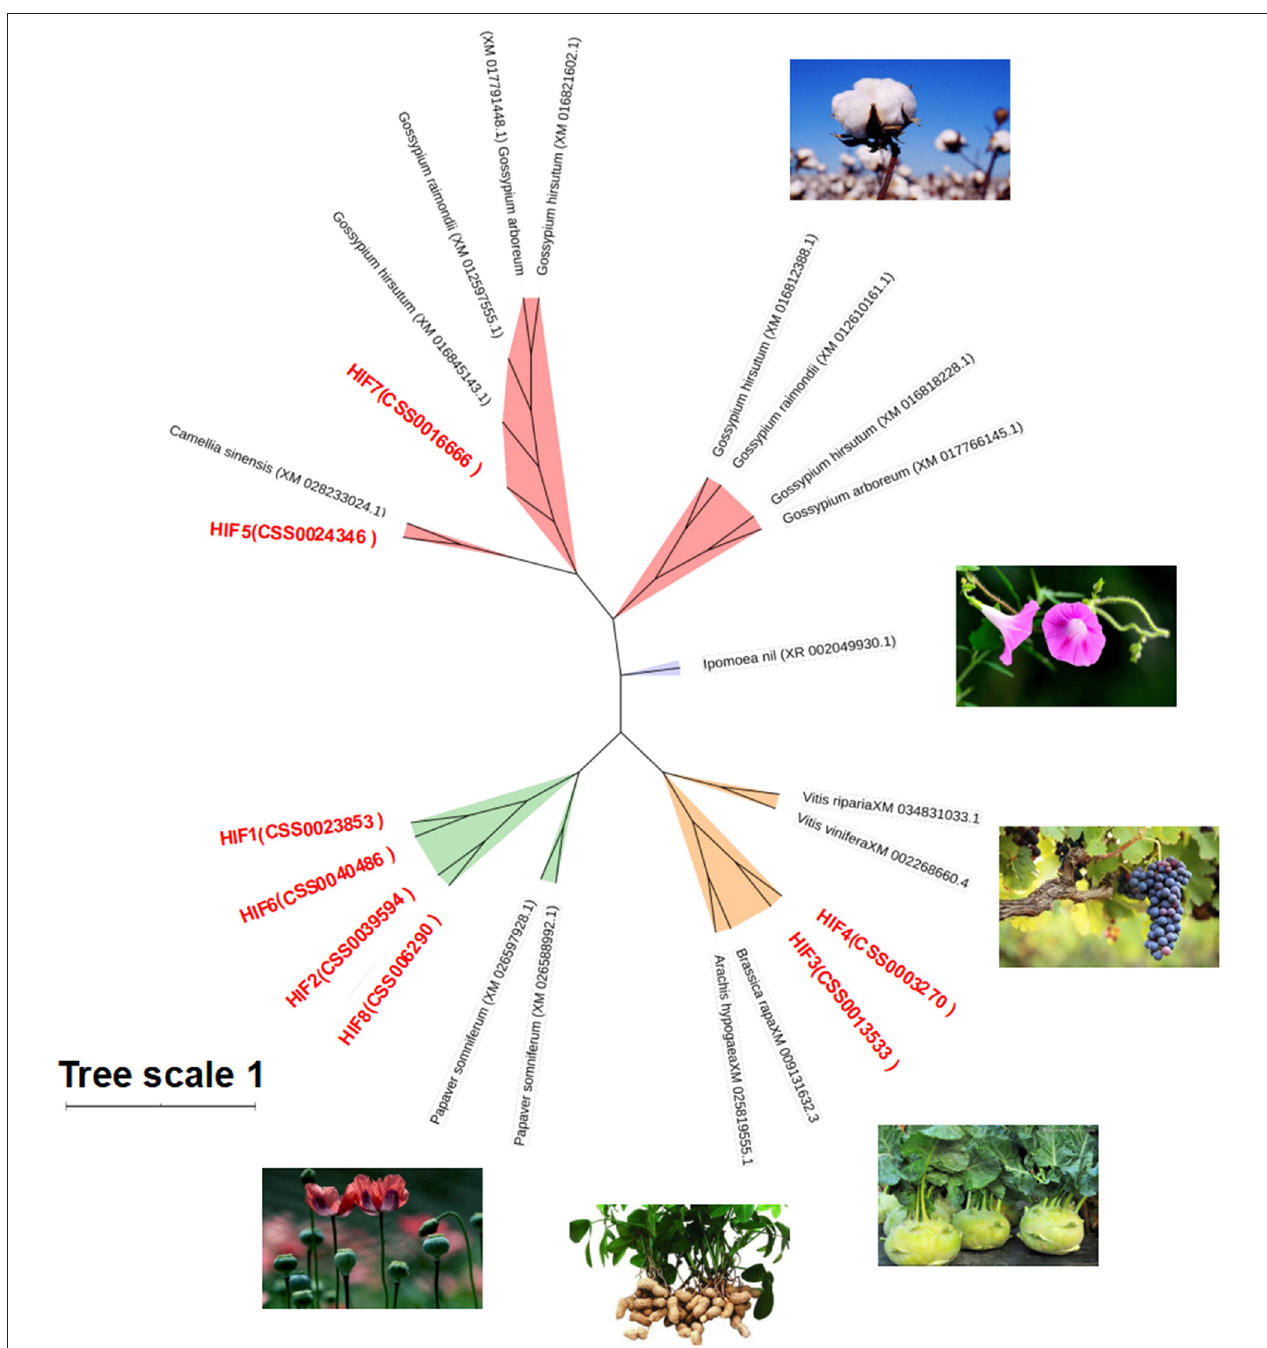
FIGURE 7 | Phylogenetic tree based on amino acid sequence homology of CsHIG proteins. Phylogenetic tree of 8 HIP genes in the tea plant and 16 ADH genes (green) in six other species: Poppy ( Papaver somniferum , XM_026597928.1 and XM_026588992.1); peanut ( Arachis hypogaea , XM_025819555.1); turnip ( Brassica rapa , XM_009131632.3); grape ( Vitis vinifera , XM_002268660.4; Vitis riparia , XM_034831033.1); Morning glory (Ipomoea nil, XR 002049930.1); and cotton ( Gossypium arboreum , XM_017766145.1 and XM_017791448.1; Gossypium hirsutum , XM_016818228.1, XM_016845143.1, XM_016812388.1, and XM_016818228.1; and Gossypium raimondii , XM_012610161.1, XM_012597555.1, and XM_012610161.1).